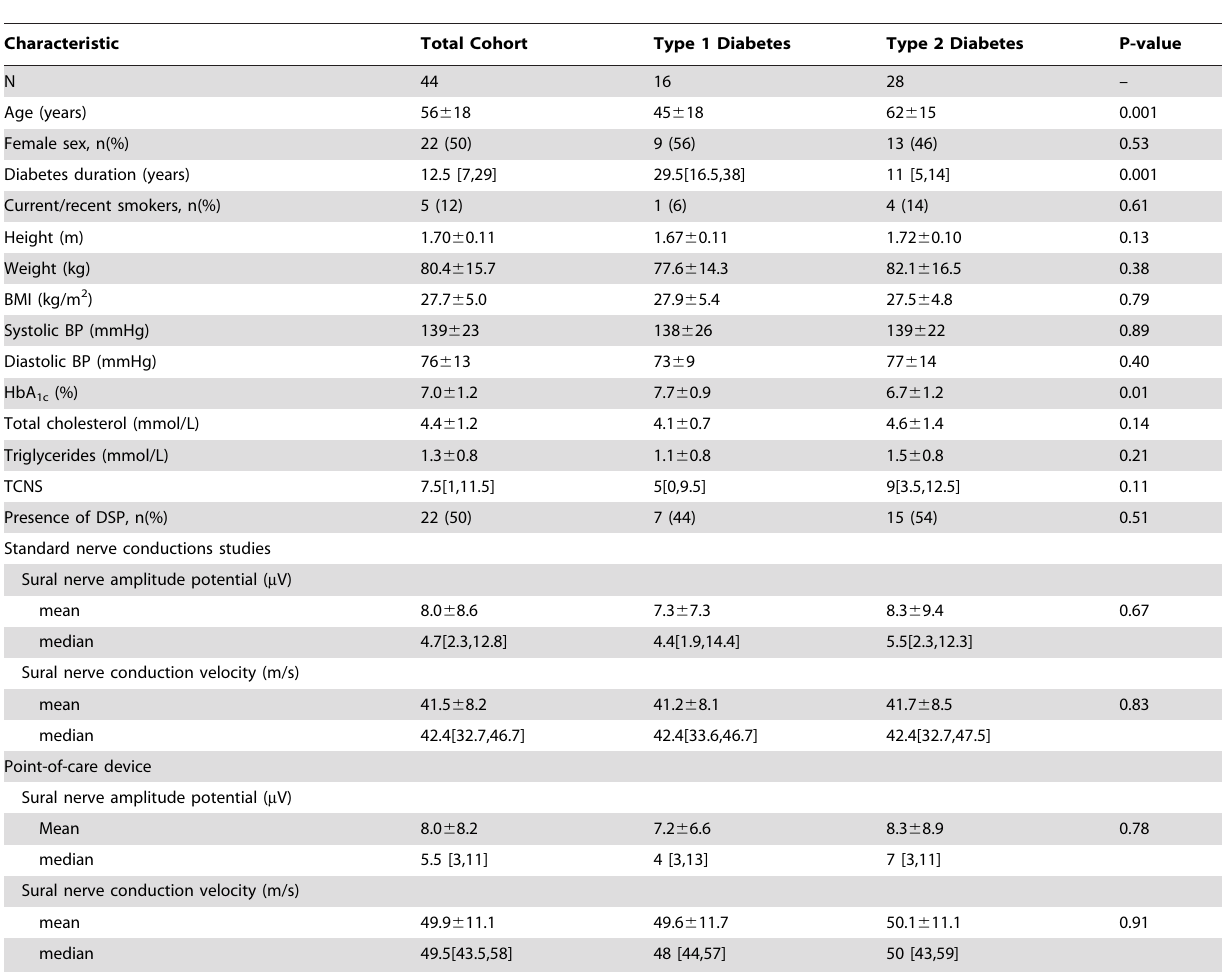
Table 1. Clinical characteristics of 44 subjects with type 1 and type 2 diabetes.